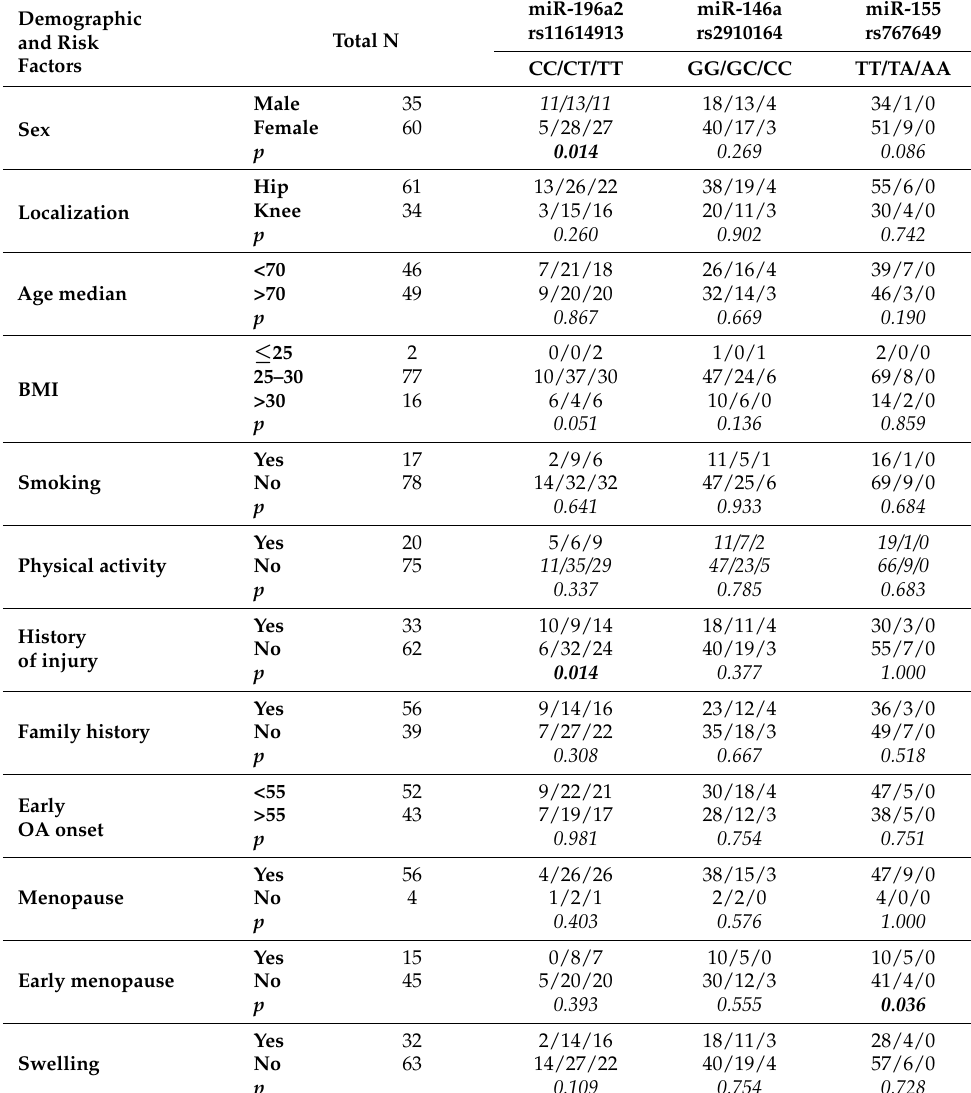
Table 3. miRNA gene variant associations with demographic and clinicopathologic features in osteoarthritis